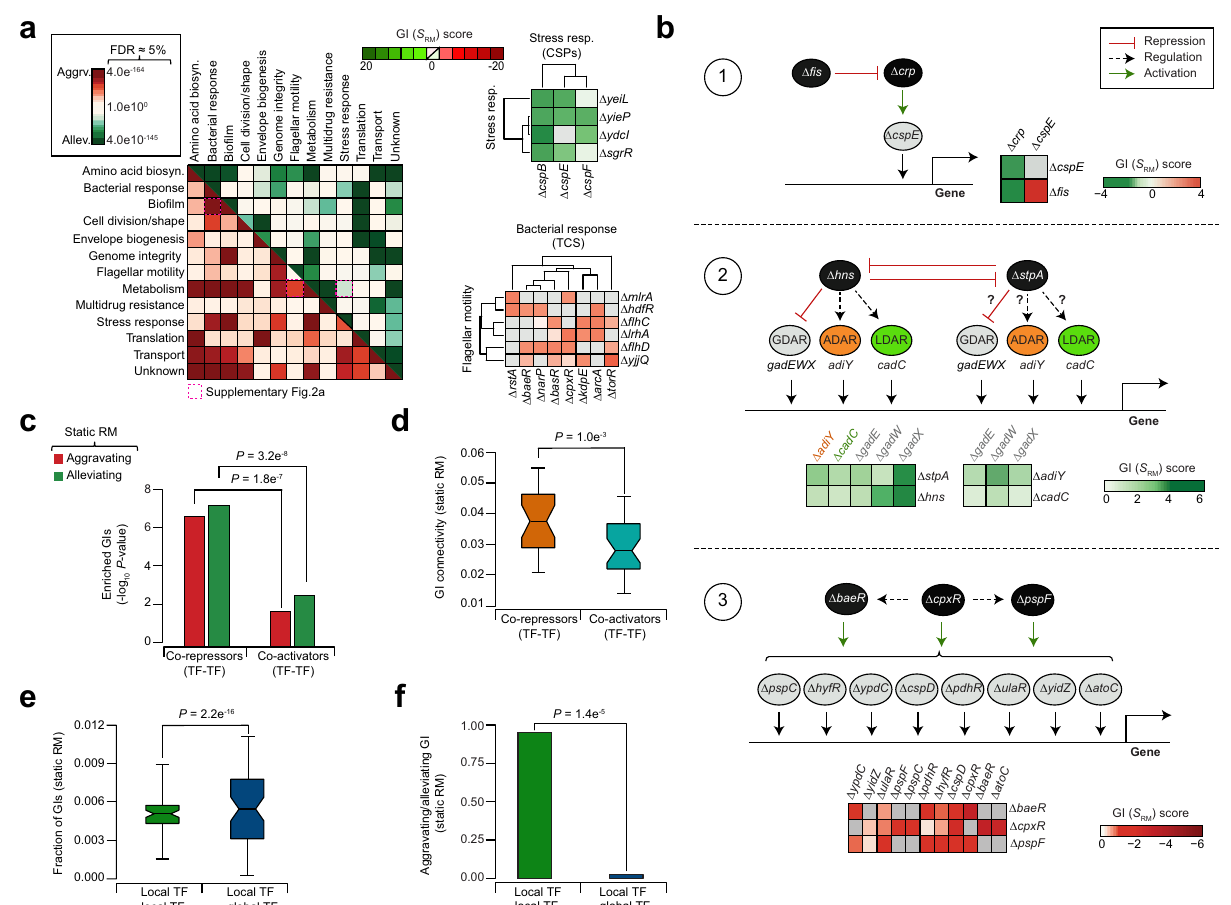
Fig. 2 Epistatic patterns/connectivity of TFs in static RM network. a Enrichment ( P -value by one-tailed hypergeometric test, and adjusted using the Benjamini-Hochberg FDR correction) of crosstalk among bioprocesses ( n = 254 of 1431 process pairs tested) with distinct aggravating or alleviating GI patterns in RM is shown along with illustrative examples (see also Supplementary Fig. 2a). b Representative regulatory modules involving TF gene pairs as regulators, activators, or repressors of gene expression, and their respective epistatic relationships are shown. Since StpA and H-NS have overlapping and distinct functions, we predict (indicated in question mark) that like hns , stpA may repress or regulate acid resistance (AR) genes based on the alleviating GI patterns with AR targets. c , d Enrichment of aggravating ( P = 1.8 e − 7 ) or alleviating ( P = 3.2 e − 8 ) GIs ( c ; from left to right, n = 17 and 27 gene pairs; P -value by hypergeometric test), and epistatic connectivity ( d ; from left to right, n = 27 and 35 genes) between TF genes that function as co-repressors or co- activators ( P = 1.0 e − 3 by two-sided Wilcoxon signed-rank test). Box plot ( d ) from left to right is shown with maximum (0.055 and 0.044), minimum (0.021 and 0.013), quartile 1 (Q1; 0.029 and 0.022), Q2 (0.037 and 0.027) and Q3 (0.047 and 0.035) values. e , f GI frequency ( e ; from left to right, n = 182 and 182 genes; P = 2.2 e − 16 by two-sided Wilcoxon signed-rank test), and ratio of aggravating to alleviating GIs ( f ; from left to right, n = 182 and 182 genes; P = 1.4 e − 5 by two-sided Wilcoxon signed-rank test) observed between local TFs compared to local with global TF gene pairs. Box plot ( e ) from left to right is shown with maximum (0.009 and 0.010), minimum (0.0015 and 0.00), Q1 (0.0041 and 0.003), Q2 (0.005 and 0.0055) and Q3 (0.0058 and 0.008) values. Source data are provided as a Source Data fi